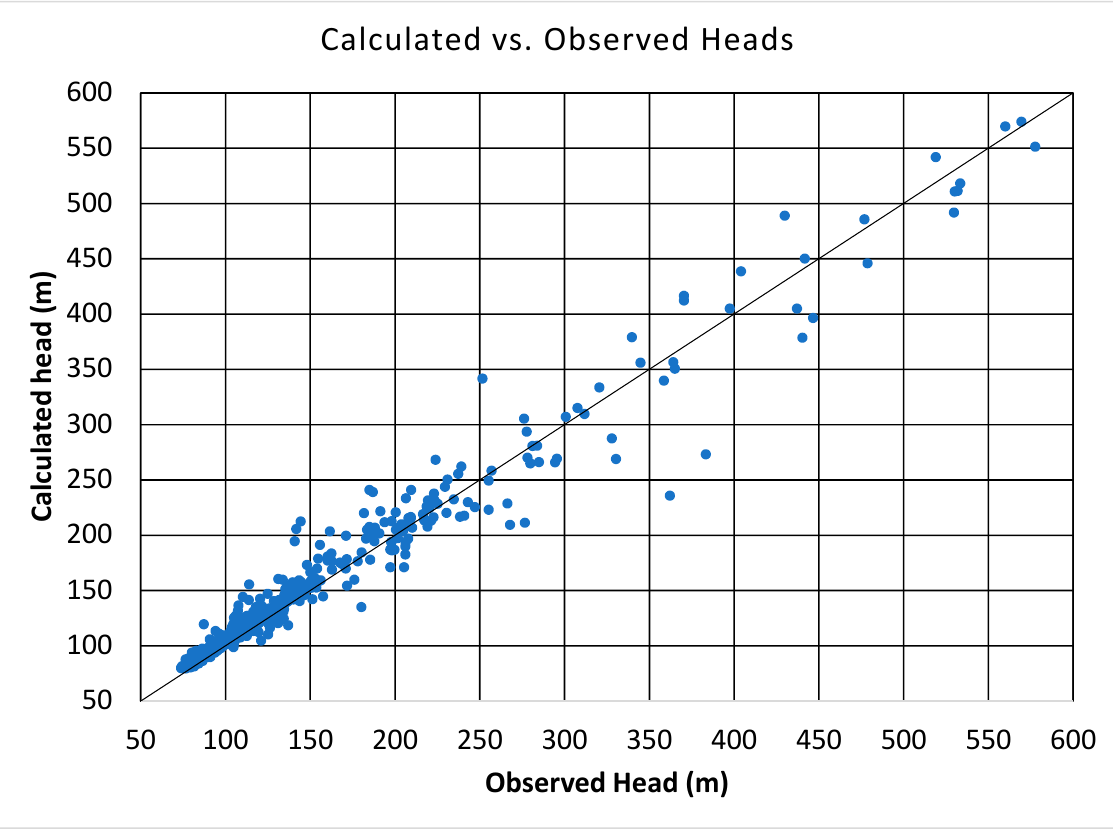
Figure 13. Scatter plot of simulated vs. observed groundwater levels of the natural-state model.